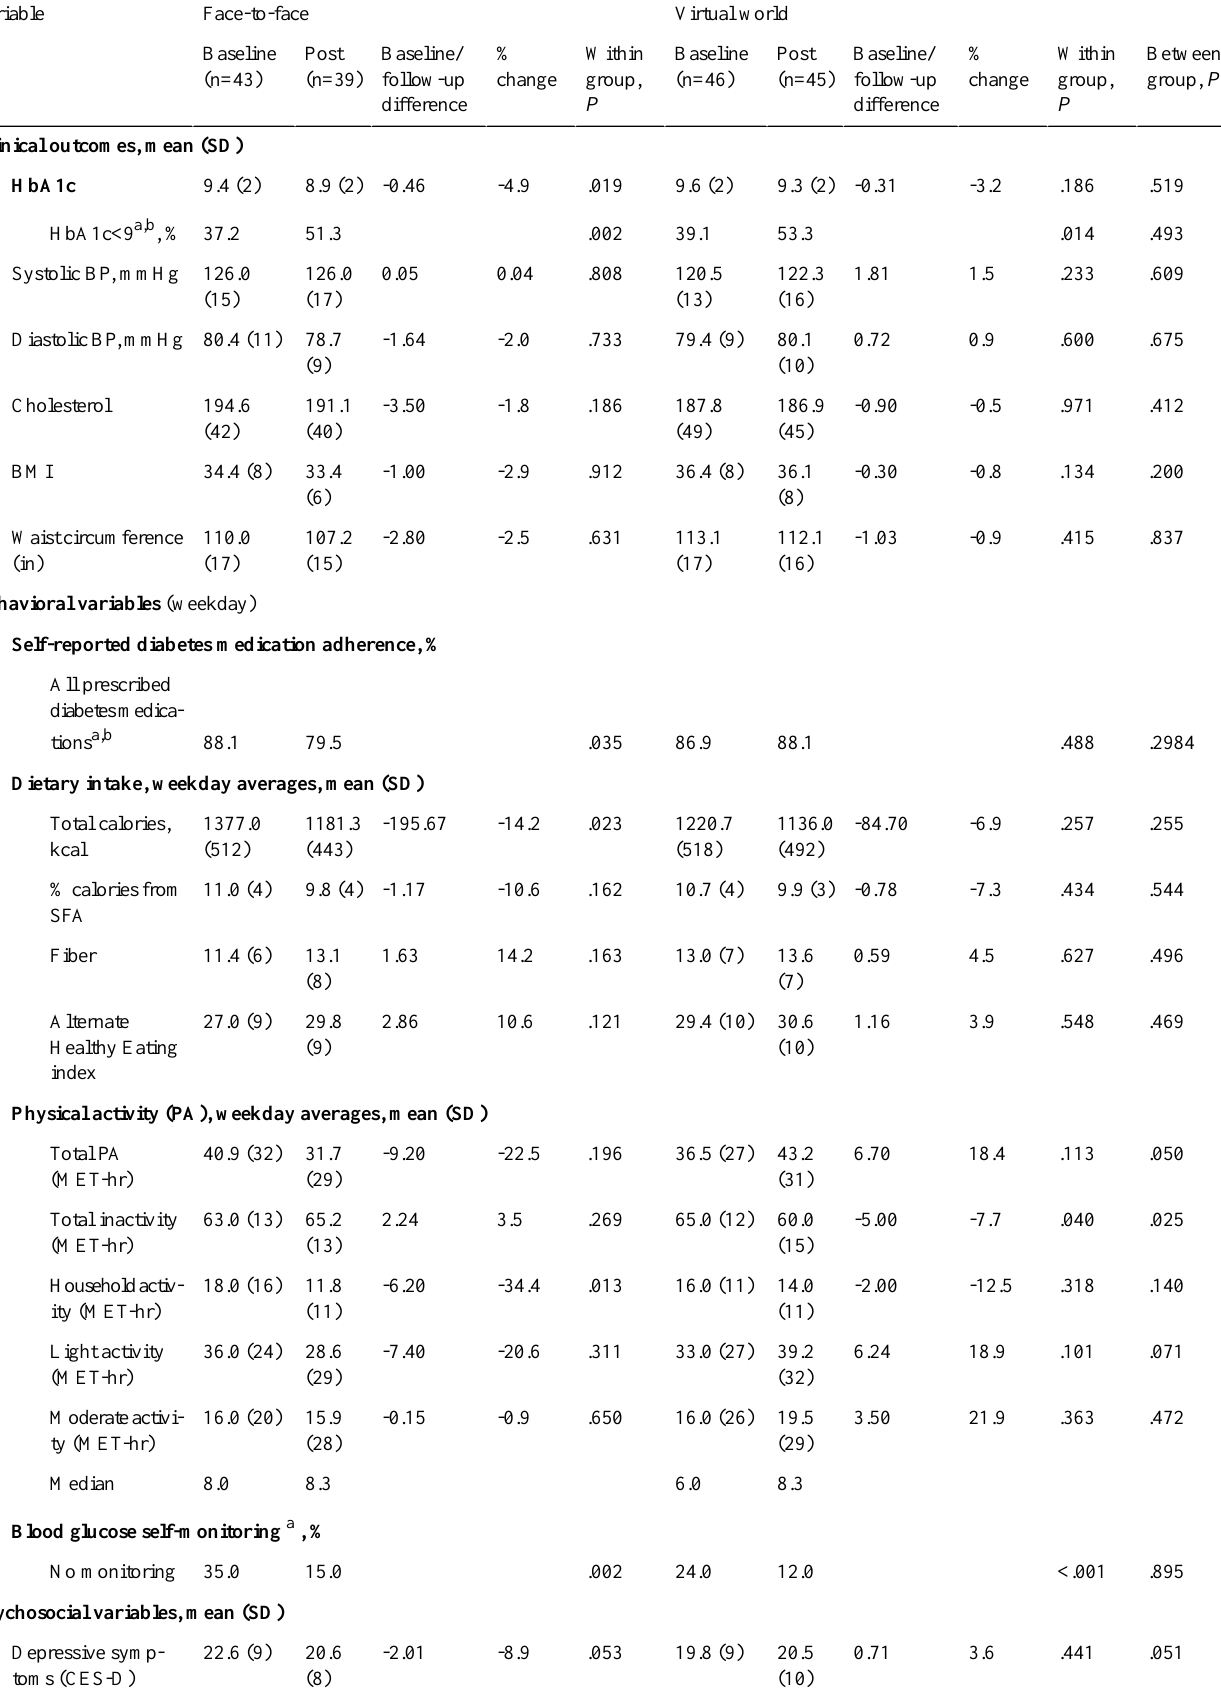
Table 2. Within group and between group comparisons for the virtual world and face-to-face intervention conditions ( P values for continuous variables derived from Student’s t test of pre-post differences, unless otherwise